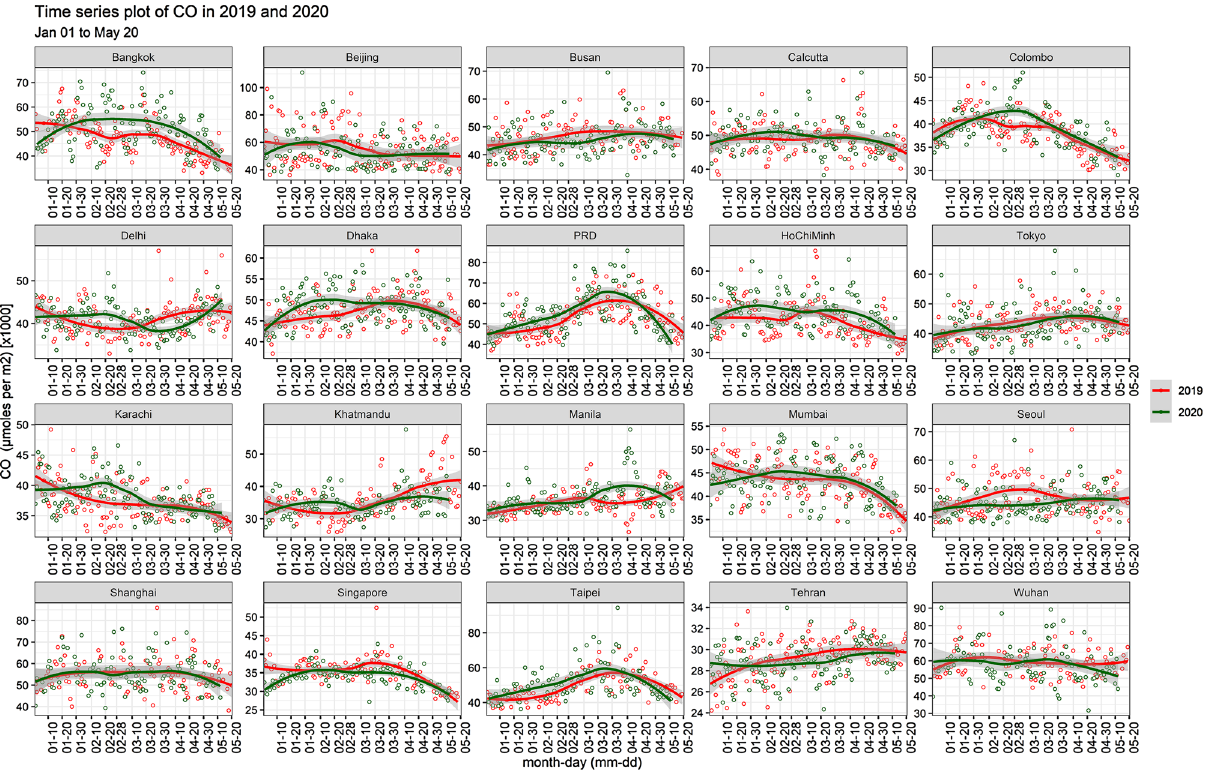
Figure 4. Comparison of daily changes in CO concentration of the cities in 2019 and